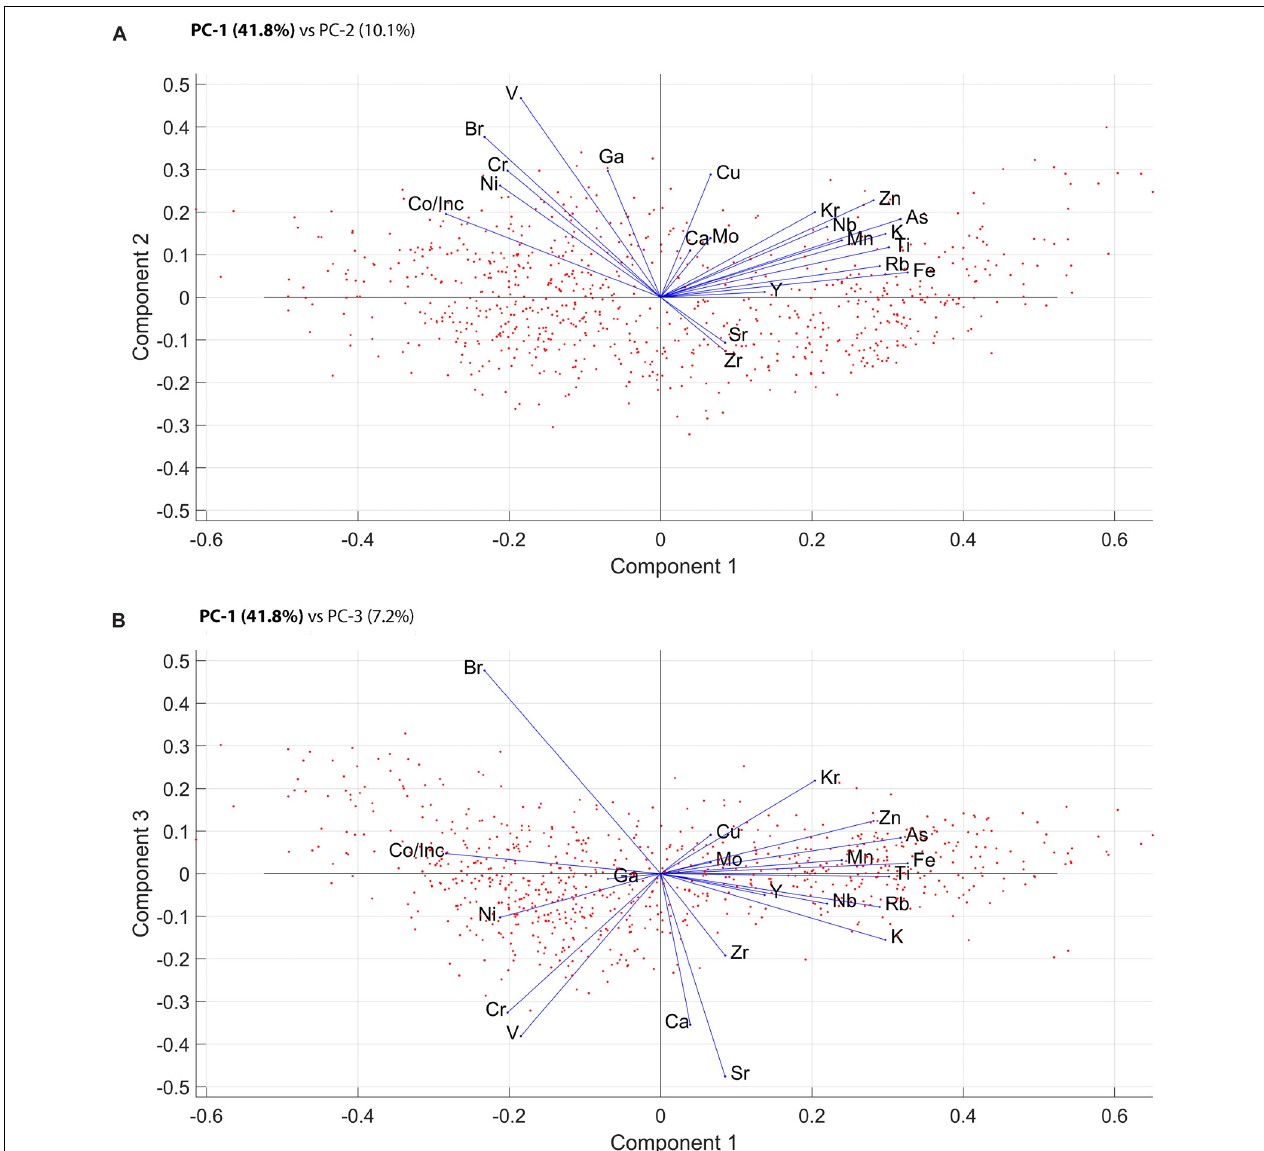
FIGURE 5 | Results of PCA analysis of the sedimentary geochemical data; (A) component 1 plotted against component 2; (B) component 1 plotted against component